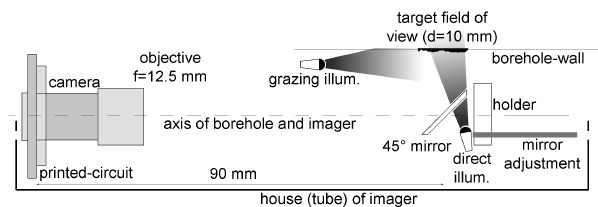
Figure 1. Schematic structure of the imager with the camera at the left that views a segment of the wall by a mirror (top right). The direct illumination provides light to the target not trough the mirror, however on this image it is visualized this way).